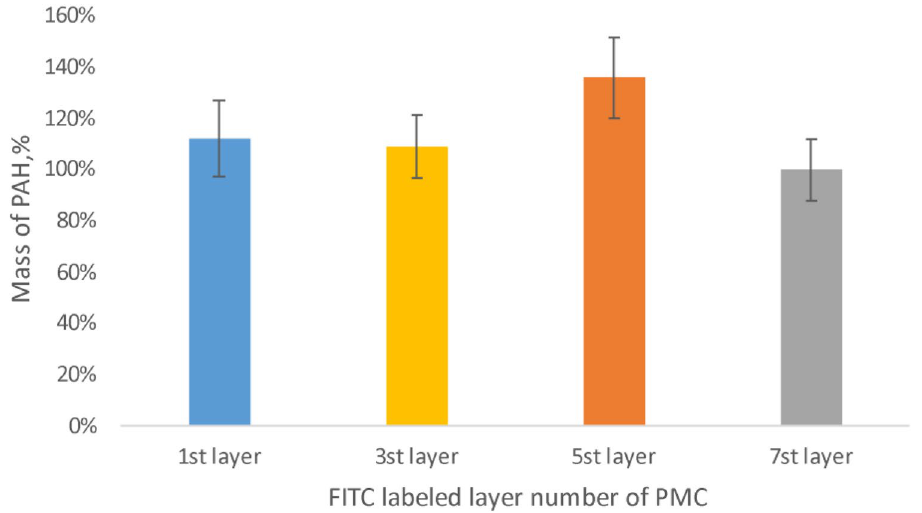
Figure 4. Dissociation of polyelectrolyte layers of microcapsules, which contained interpolyelectrolyte complex, incubated in 2 M NaCl